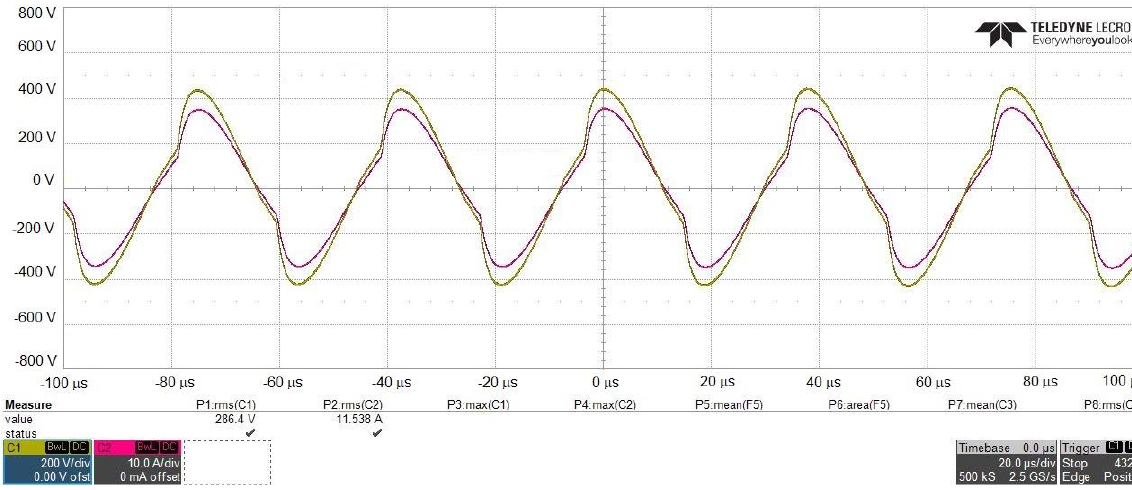
Figure 30. Receiver coil voltage (C1, green) and current (C2, purple) at 31 kHz.